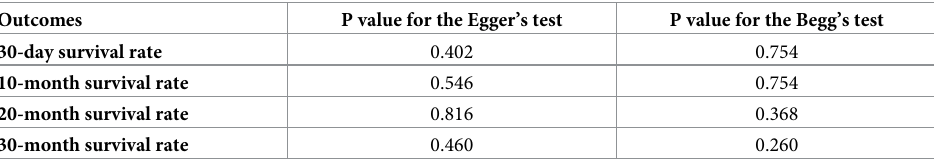
Table 4. Publication bias